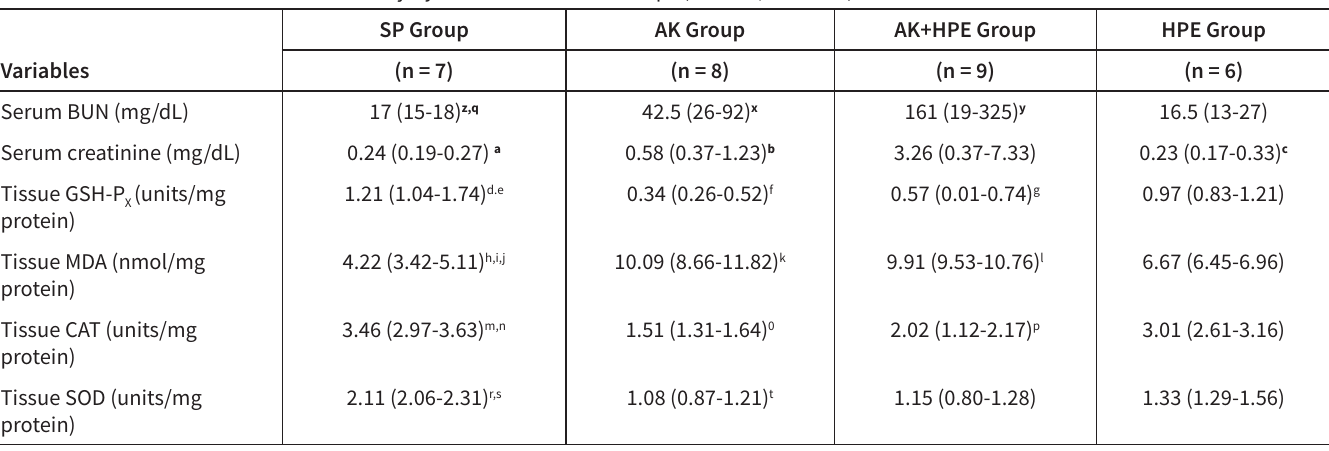
Table 1. The Biochemical and Oxidative Injury Parameters of the Groups (Median; Min-Max)